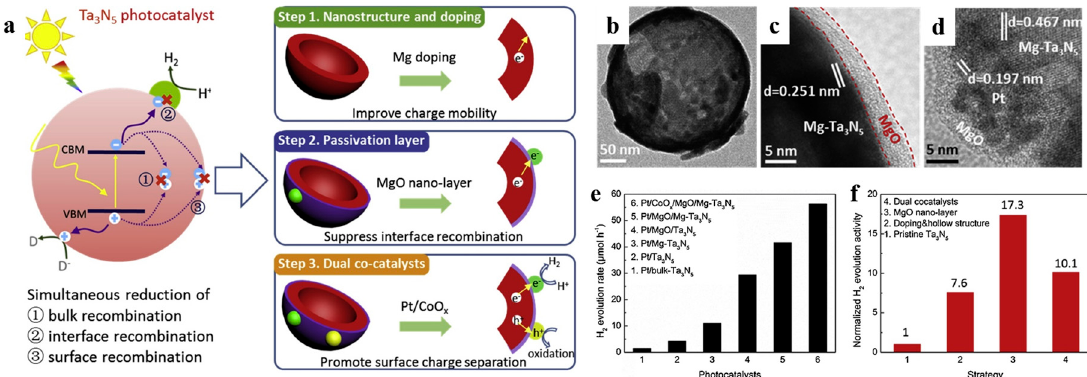
Figure 19. ( a ) Schematic diagram of how these three proposed approaches solve the recombination problems synergistically during the photocatalytic process of Ta 3 N 5 . Red, purple, green, and yellow objects represent Ta 3 N 5 , MgO, Pt, and CoO x respectively. TEM images of ( b ) Mg-Ta 3 N 5 , ( c ) MgO / Mg-Ta 3 N 5 and ( d ) Pt / CoO x / MgO / Mg-Ta 3 N 5 hollow spheres. ( e ) Hydrogen generation rates of Pt / Ta 3 N 5 , Pt / Mg-Ta 3 N 5 , Pt / MgO / Ta 3 N 5 , and Pt / CoO x / MgO / Mg-Ta 3 N 5 . ( f ) Comparison between the contributions of each approach to improve the photocatalytic ability of Pt / CoO x / MgO / Mg-Ta 3 N 5 photocatalyst irradiated under simulated sunlight. Reproduced with permission from [62]. Copyright Elsevier, 2019.